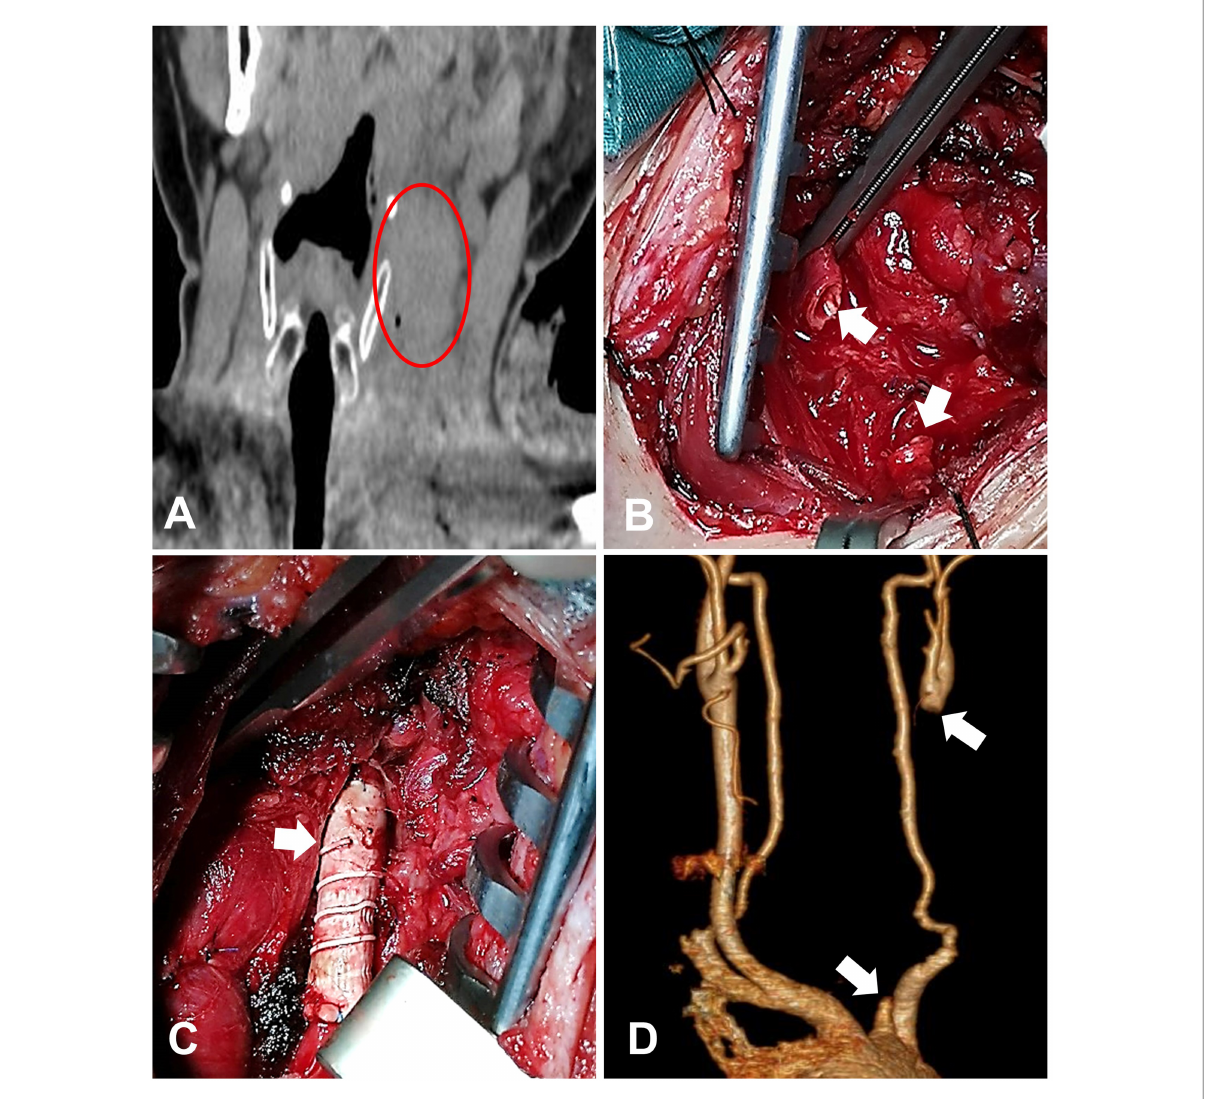
FIGURE 1 Case 1: ( A ) coronal CT of the neck showed massive blood clots around the left carotid artery, which compressed and displaced the trachea. Note: the red circle is marked in the left carotid sheath. ( B ) Intraoperative exploration of left common carotid artery amputation. Note: the arrow is marked as the broken end of the left common carotid artery. ( C ) Place the image of an arti fi cial vascular anastomosis. Note: the arrow is marked after arti fi cial vascular implantation. ( D ) Three-dimensional postoperative computer tomographic scan showing a clogged left carotid. Note: the arrow points to the broken end of the left common carotid